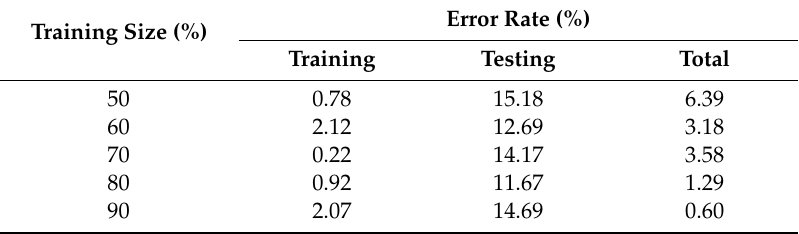
Figure 7. Total absorption chiller energy consumption forecast results. Table 6. Error rate of the total absorption chiller energy consumption forecast results.